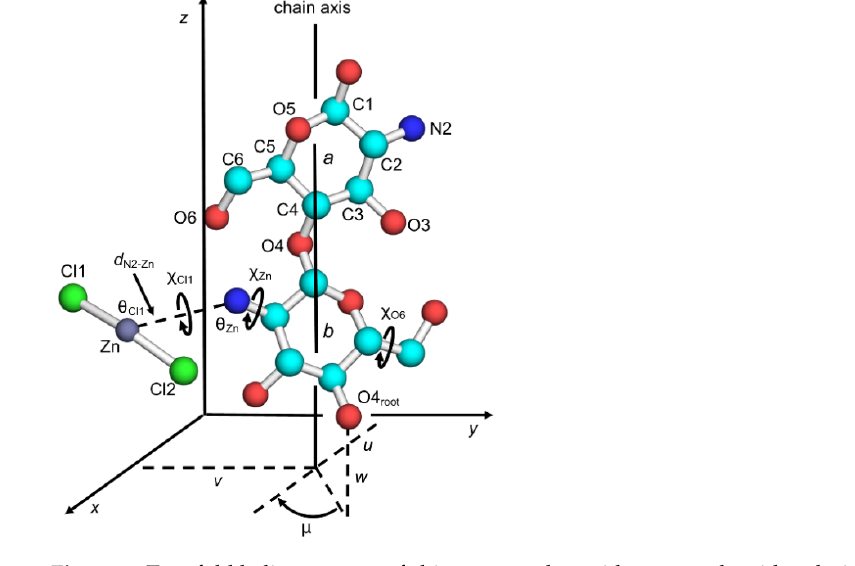
Figure 1. Two-fold helix structure of chitosan together with atom and residue designations. Notation is as follows: chain packing parameters ( μ , u , v , and w ), hydroxymethyl conformation ( χ O6 ), and ZnCl 2 position parameters ( χ Zn , χ Cl1 , θ Zn , θ Cl1 , and d N2–Zn ).